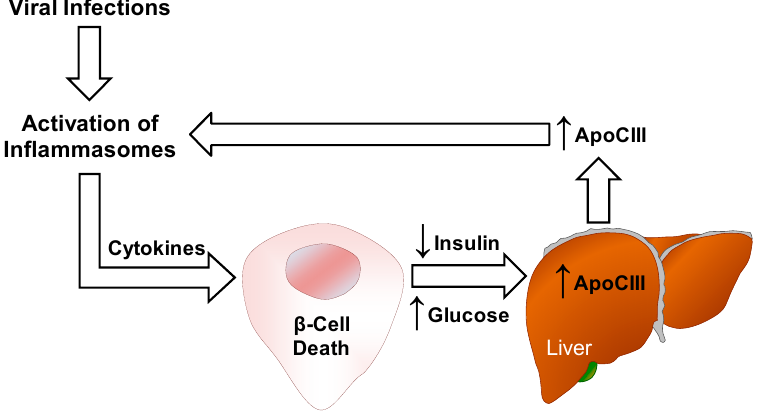
Figure 1. Possible mechanisms by which viral infections can induce β -cell death. Activation of inflammasomes and cytokine release upon viral infections can be participating in β -cell death leading to insulin deficiency and hyperglycemia. This results in elevated apoCIII, which mediates an alternative activation of inflammasomes.